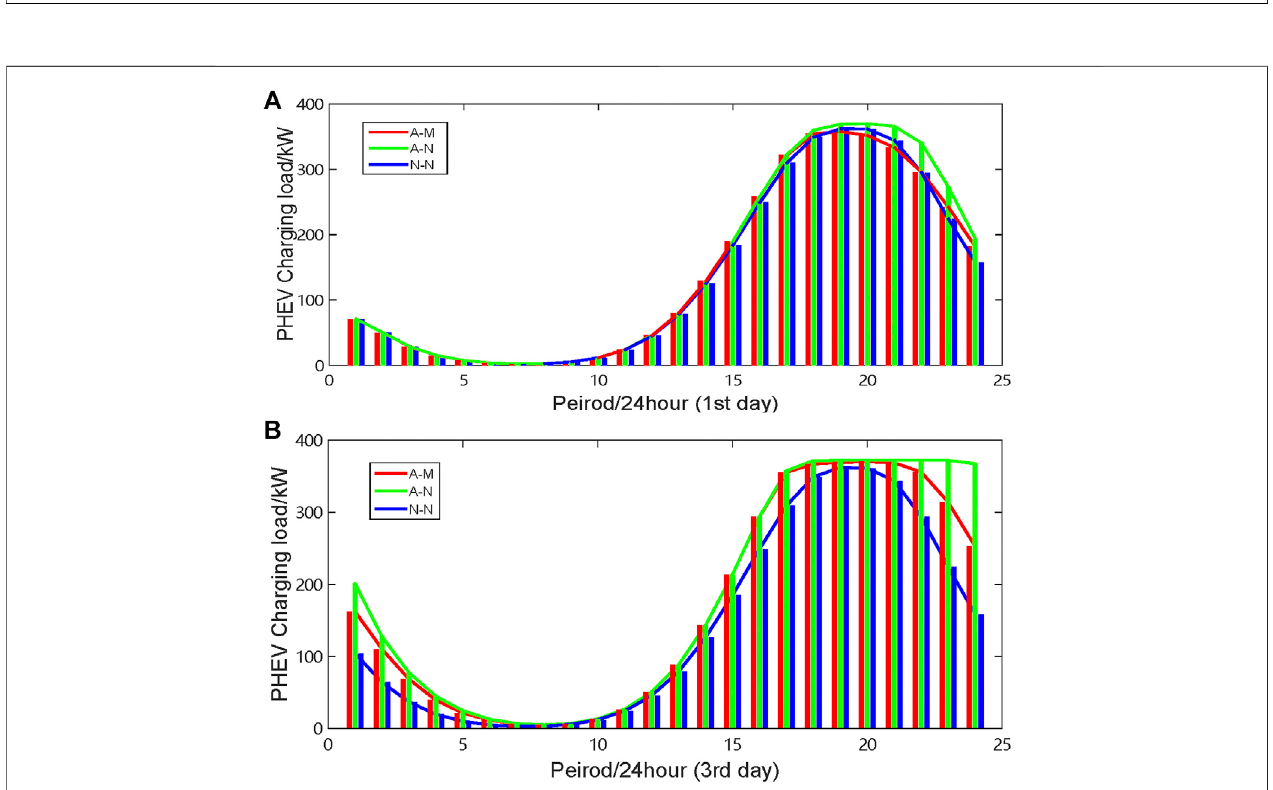
FIGURE 8 | Load variation of charging station C. (A) Charging load in the fi rst 24 h (1 st day). (B) Charging load in the third 24 h (3 rd day).